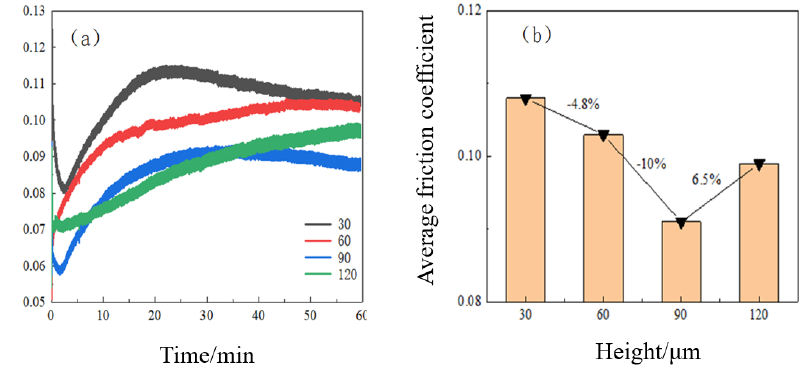
Figure 25. Influence of height on the surface friction coefficient. ( a ) Friction coefficient curve, ( b ) Average friction coefficient.